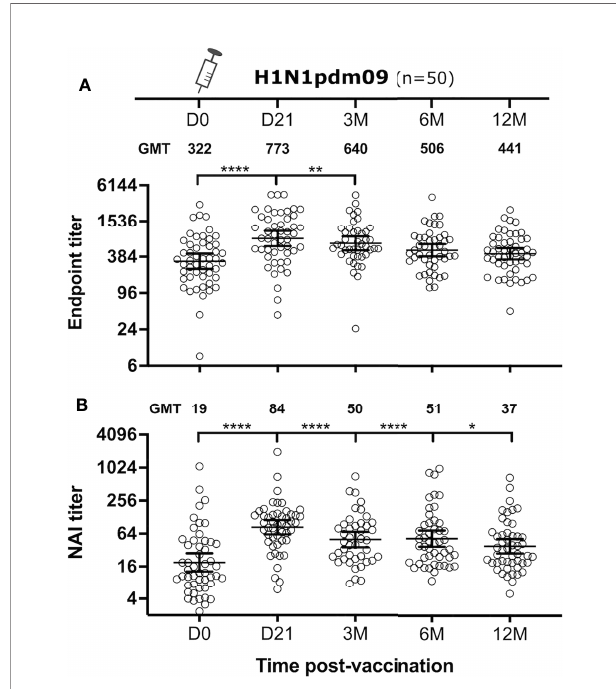
FIGURE 1 | NA-speci fi c antibody responses after H1N1pdm09 vaccination. Health care workers (n = 50) were vaccinated with AS03-adjuvanted H1N1pdm09 vaccine. The NA-speci fi c antibody response was measured before and 21 days, 3, 6 and 12 months after vaccination (D0, D21, 3M, 6M, 12M, respectively). Endpoint titers were measured by ELISA (A) and NA inhibition (NAI) titers were measured by ELLA (B) . Each subject is shown as one symbol with geometric mean and 95% con fi dence intervals. A linear mixed effects model was used for statistical analyses between pre- and post- vaccination titers with adjustments for demographic factors. *P ≤ 0.05, **P ≤ 0.01, ****P ≤